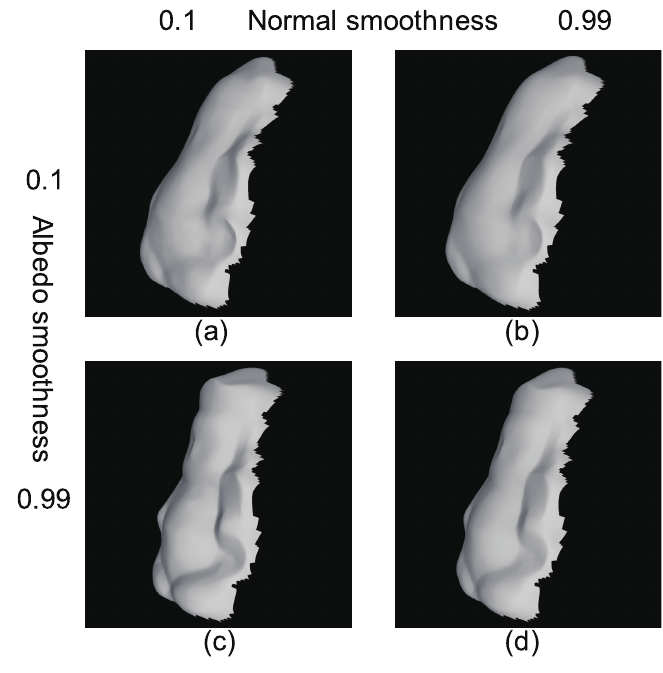
Figure 32. How the weight of smoothness term affects the results: ( a ) Sharp normal and sharp albedo, ( b ) smooth normal and sharp albedo, ( c ) sharp normal and smooth albedo, and ( d ) smooth normal and smooth albedo.